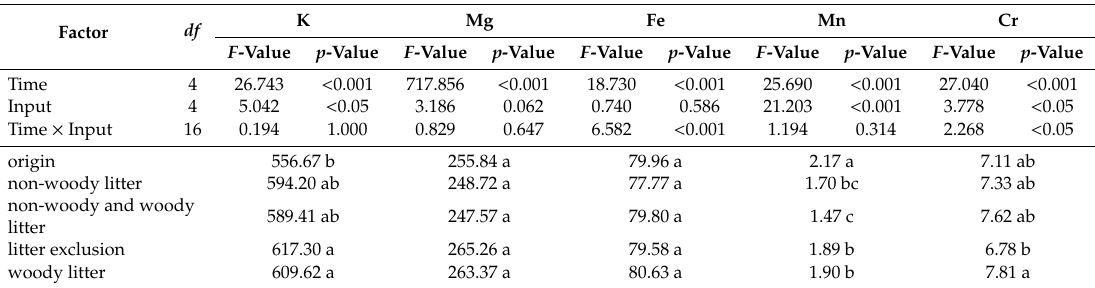
Table 2. E ff ects of time, debris input and their interaction on metals concentration of water tested by repeated-measure ANOVA analyses.